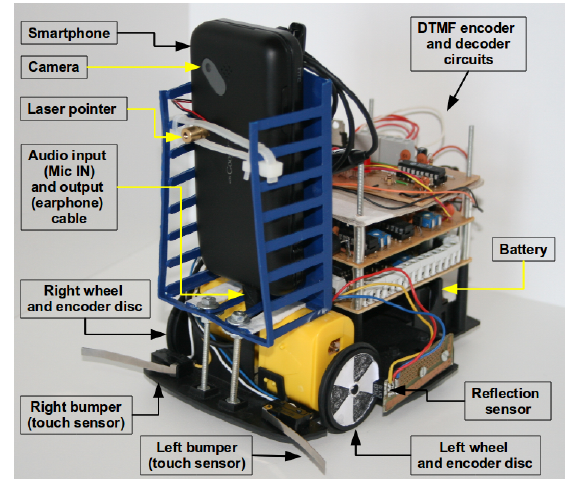
Figure 10. Robot under the control of a mobile phone. The audio input and output channels are connected in a single connector below the phone.